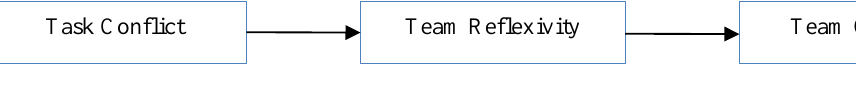
Fig. 1 : The hypothesized